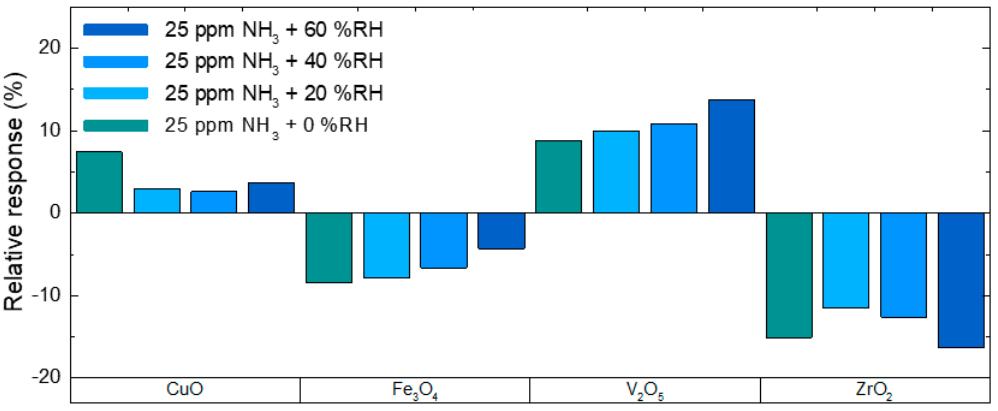
Figure 4. Relative responses of NL DEG samples for 25 ppm NH 3 exposures at 75 °C (except ZrO 2 at 125 °C) at different levels of RH.